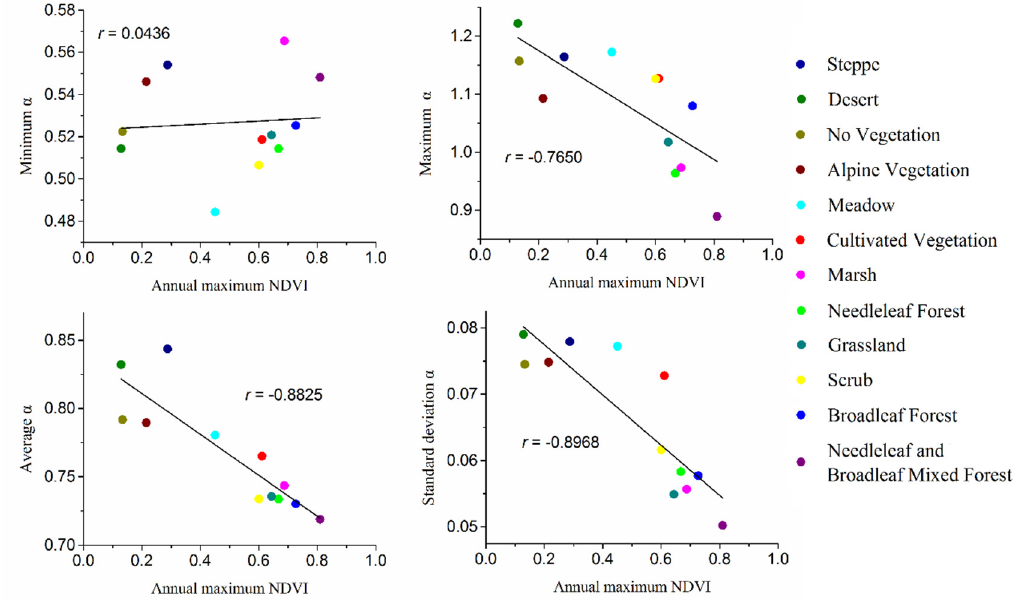
Figure 9. Relationships between the minimum, maximum, average value and standard deviation of the exponent α and the annual maximum NDVI for each vegetation